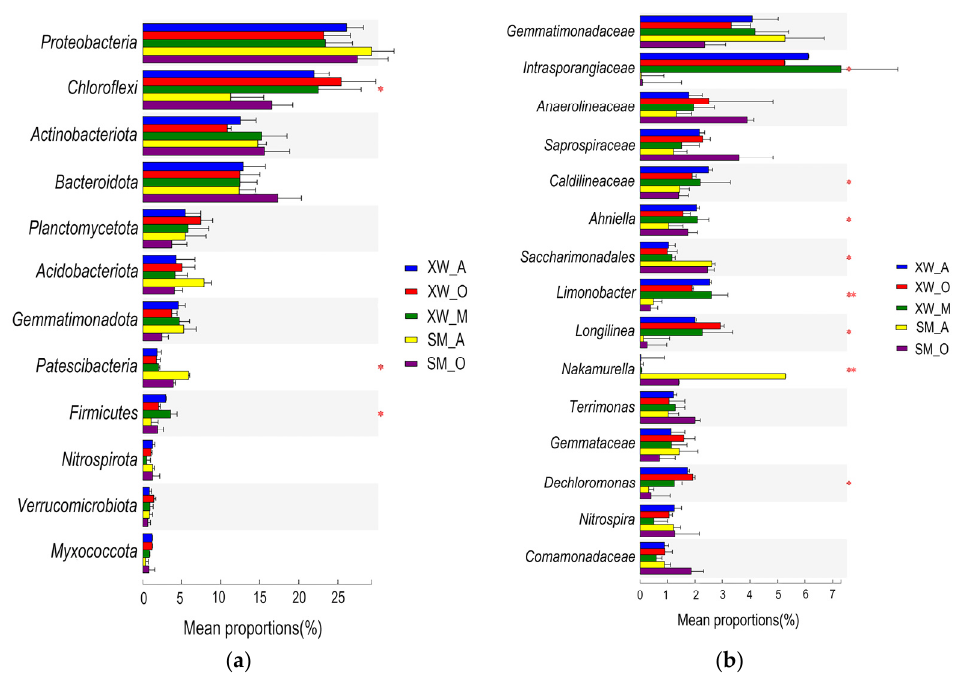
Figure 4. The relative abundance variation of top bacteria in the samples of WWTPs: ( a ) phylum level; ( b ) genus level. Note: * 0.01 < p < 0.05; ** 0.001 < p < 0.01.